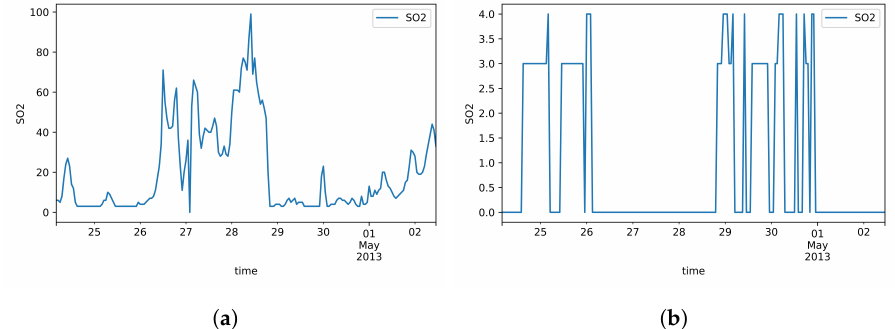
Figure 4. SO2 over 200 samples in Beijing Multi-Site Air-Quality. ( a ) Actual data; ( b ) Generated missing